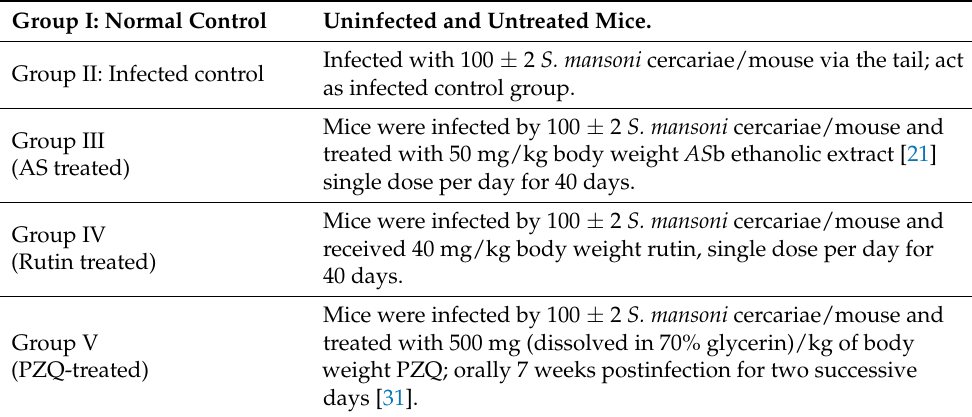
Table 1. Experimental